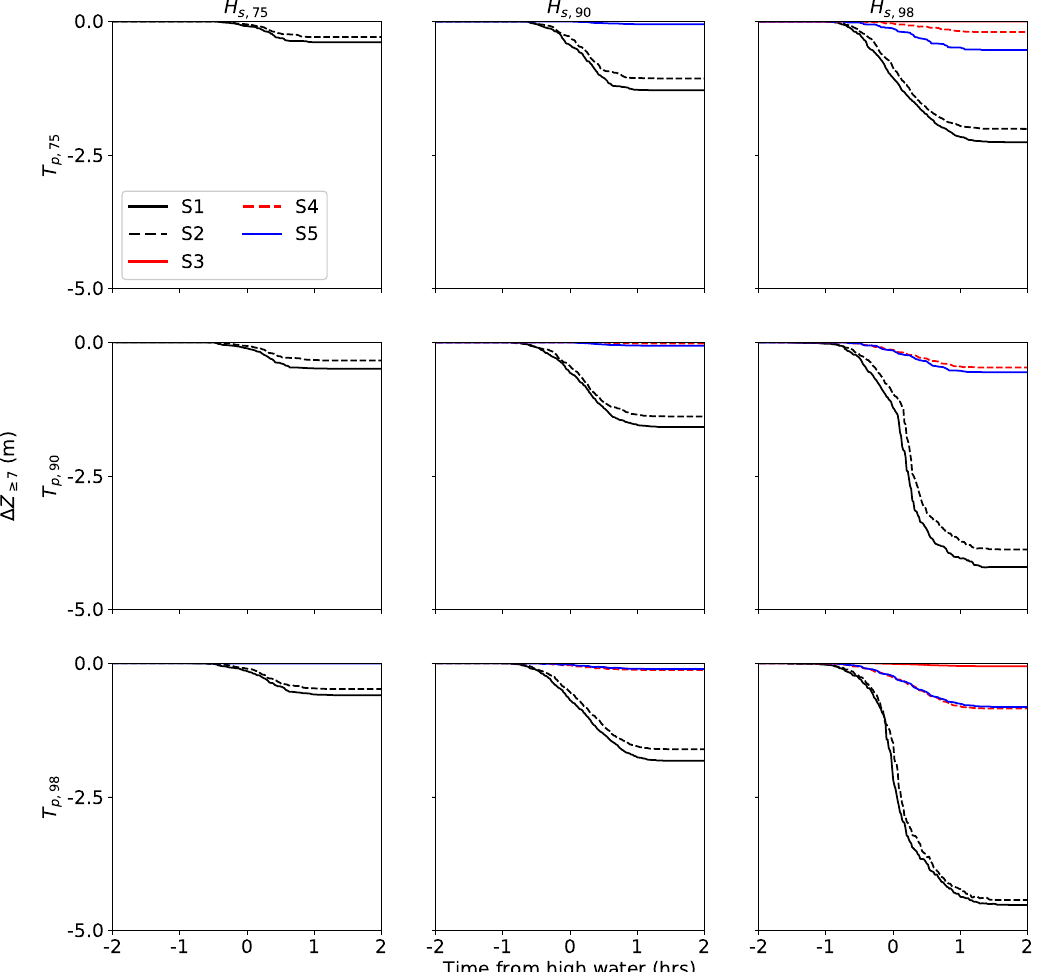
Figure 9. Cumulative integrated elevation change of the barrier crest (above 7 mODN) using S1 to S5 for each H s and T p combination under the highest astronomical